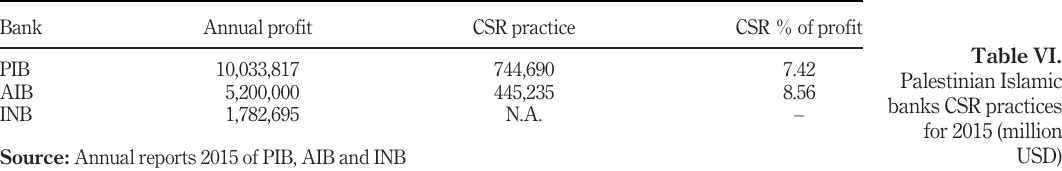
Table VI. Palestinian